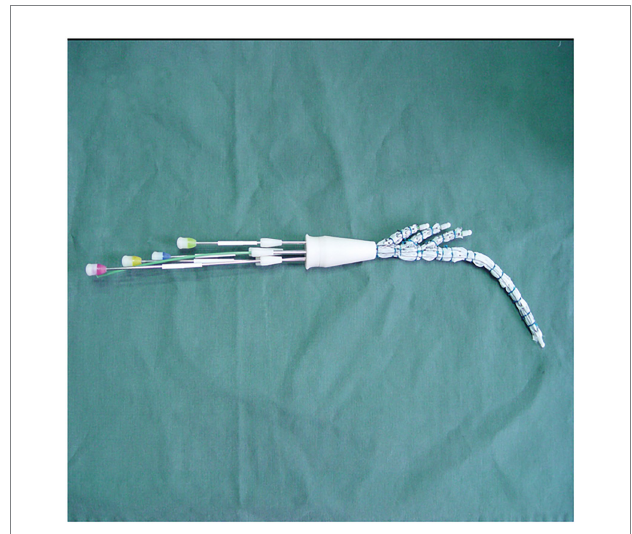
FIGURE 1 The modified triple-branched stent graft is comprised of a main graft and three sidearm grafts.